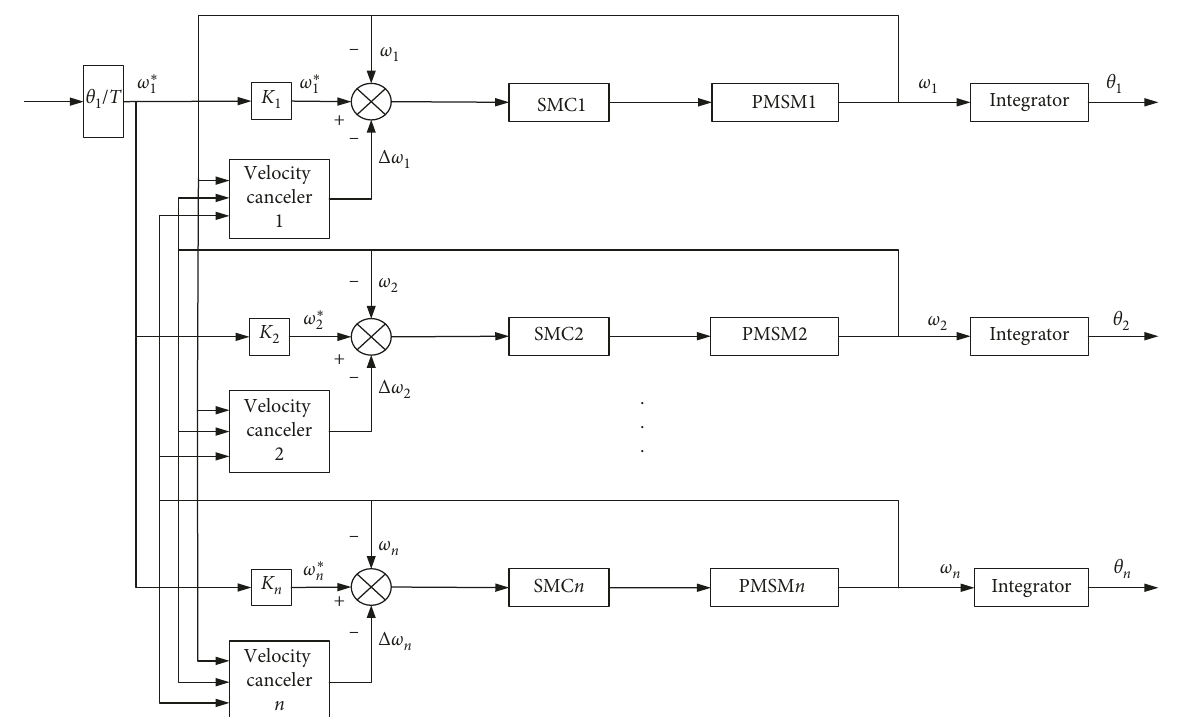
Figure 1: Block diagram of the sliding mode controller based on the multiaxis servo synergic